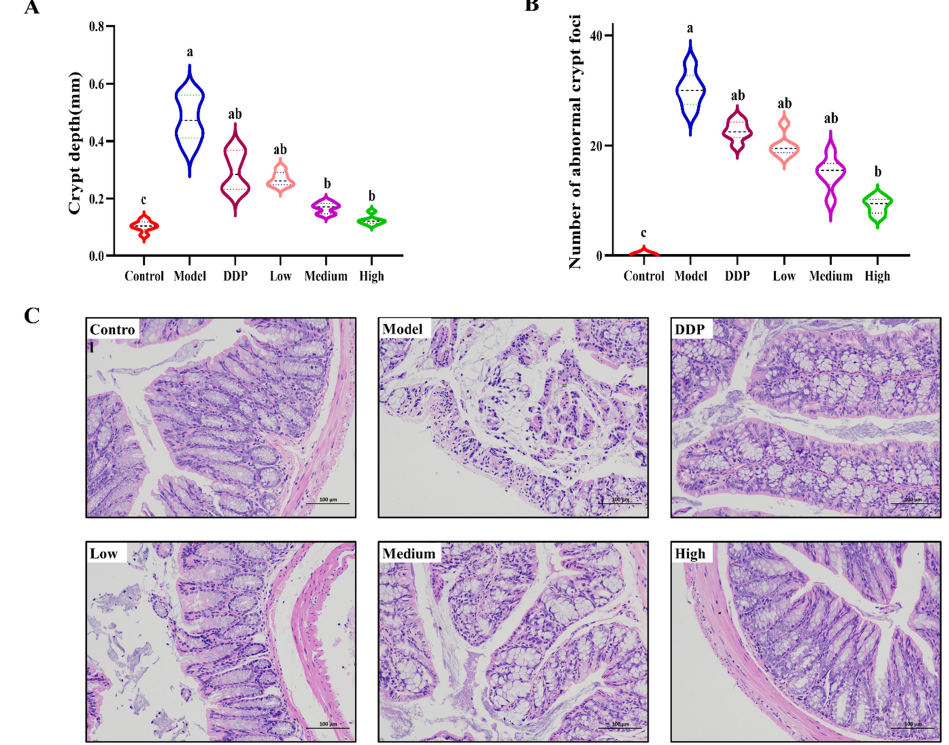
Figure 2 . Effect of SCS on the colorectum in a mouse model of HT-29 allograft tumors. Effects of SCS treatment on the crypt depth in colorectal epithelial tissues ( A ); Effects of SCS treatment on the number of abnormal crypt foci in colorectal epithelial tissues ( B ); Typical diagrams of HE stained cells in colorectal epithelial tissues with SCS (×100) ( C ). Results are expressed as mean ± SEM ( n = 5). Different superscript letters for each column indicate significant differences ( p < 0.05) as com- pared to every other group. 2.3. SCS Treatment Alters the Structure of Gut Microbiota Recent studies have indicated that a dysregulation of gut microbiota plays a critical role in the development and the progression of several diseases, including colon cancer and liver cancer [6,23]. Therefore, we sought to investigate whether SCS treatment can affect the composition of gut microbiota. We used 16S rRNA sequencing technology to study the microbiota of colonic content of mice in each group. As shown in Figure 3A, the differences in microbial composition among the four groups are clearly shown in the Venn diagram. The number of OTUs in the Control, Model group, DDP group, and the High